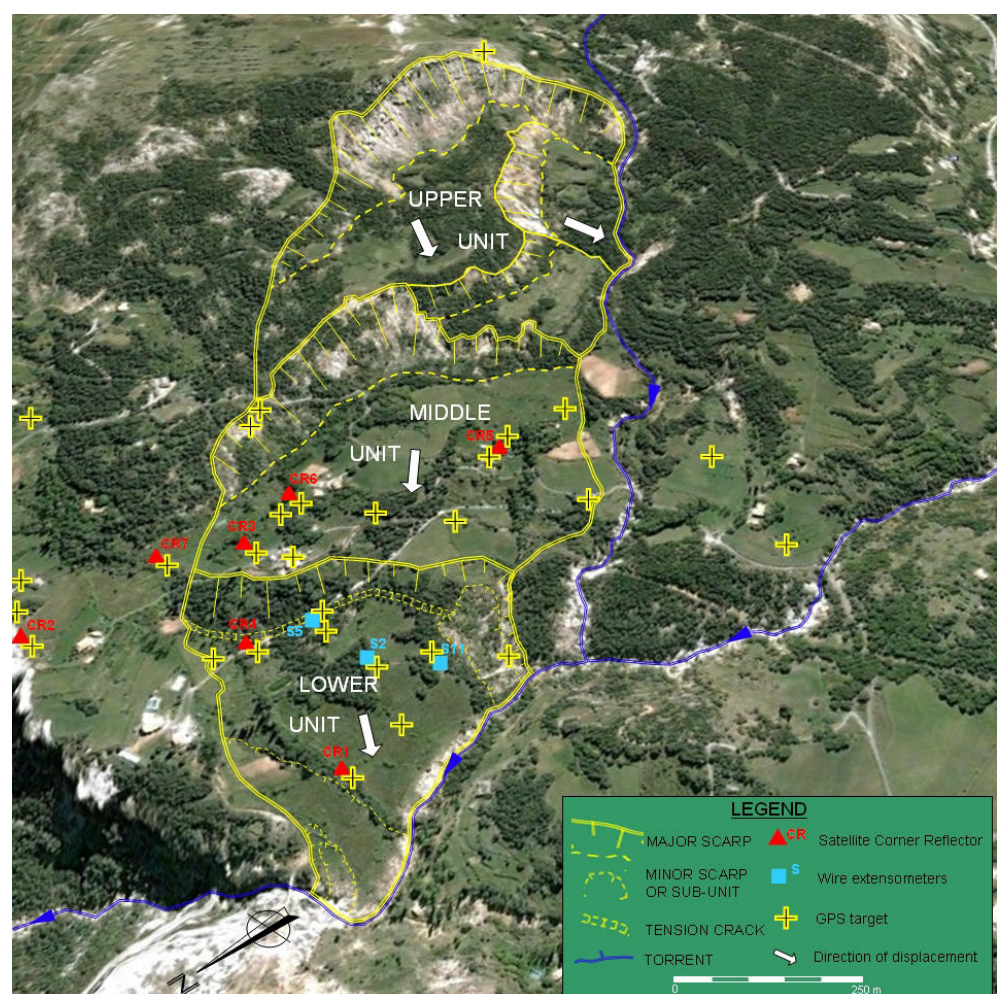
Figure 1. Geomorphologic scheme of the Vallcebre landslide superimposed over an aerial image. The upper, middle and lower units, separated by scarps, can be appreciated. Several GPS, corner reflector and wire measuring points are marked with symbols. Image courtesy of the Institut Cartogràfic de Catalunya.